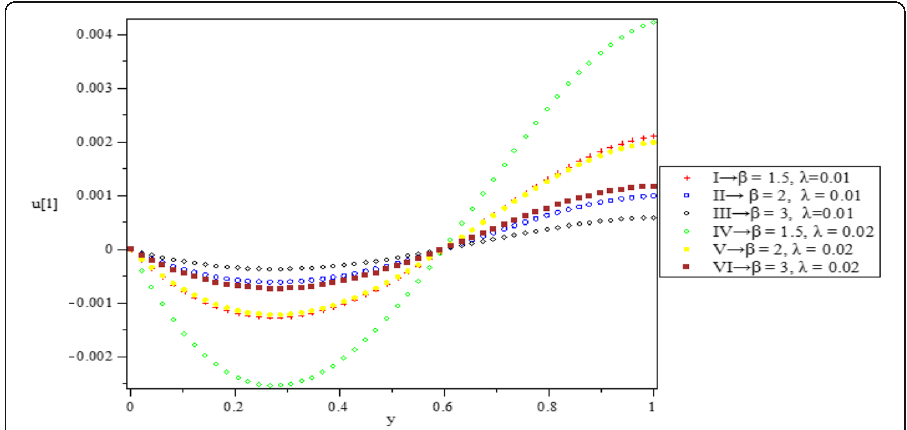
Fig. 20 First-order velocity (u[1] profile, r = − 1, ϵ = 0.25, P = 0.71 α = − 5, and G =